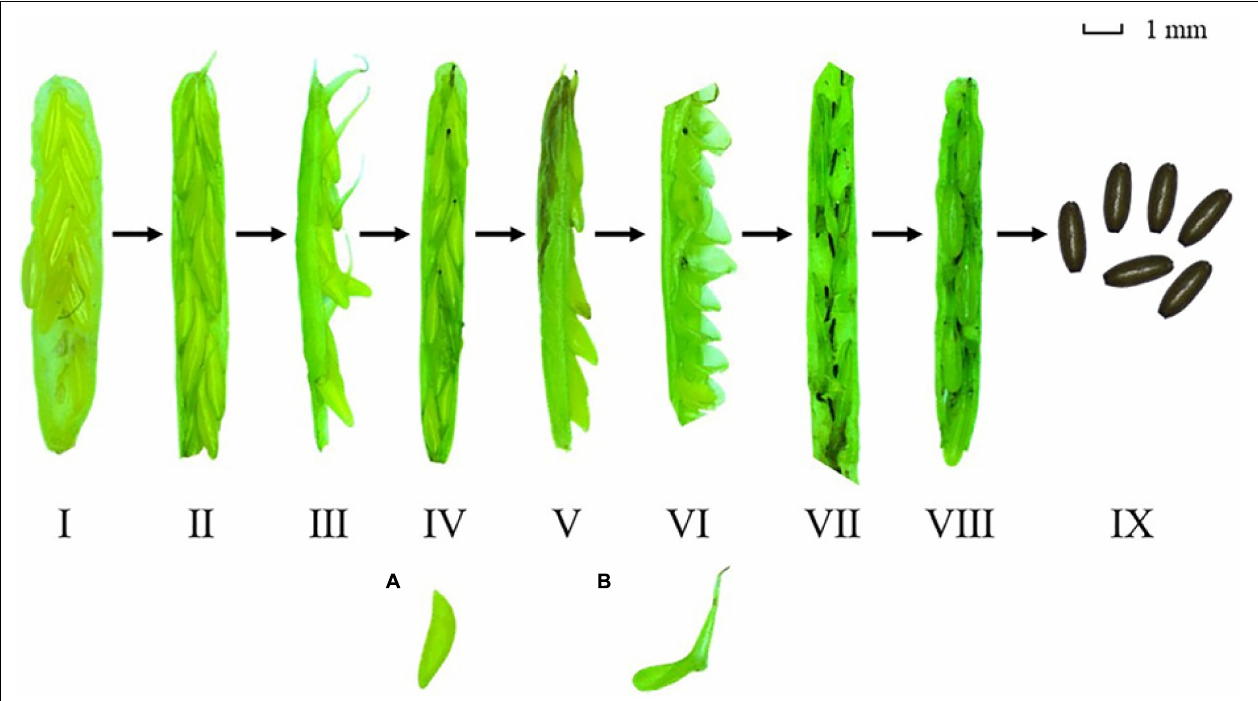
FIGURE 8 | The Zostera japonica spathe developmental process and the morphology of male (A) and female (B) flowers.